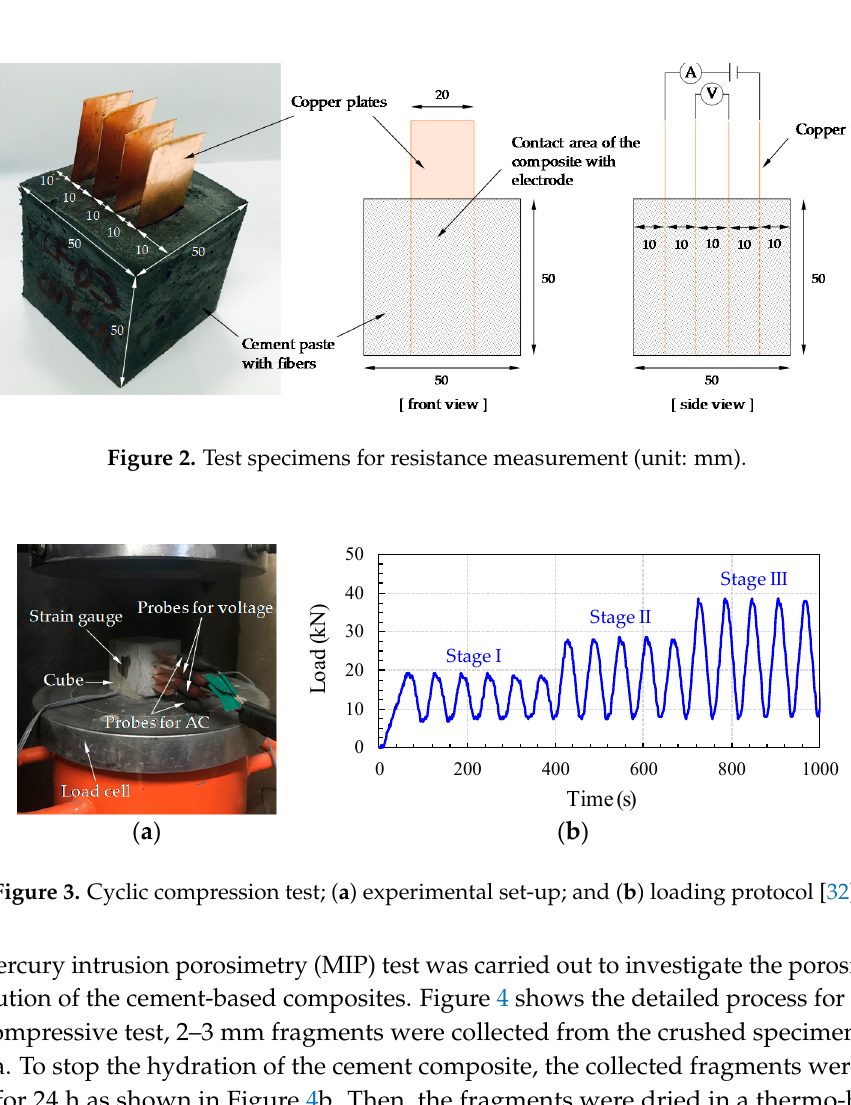
Sensors 2017 , 17 , 2516 5 of 16